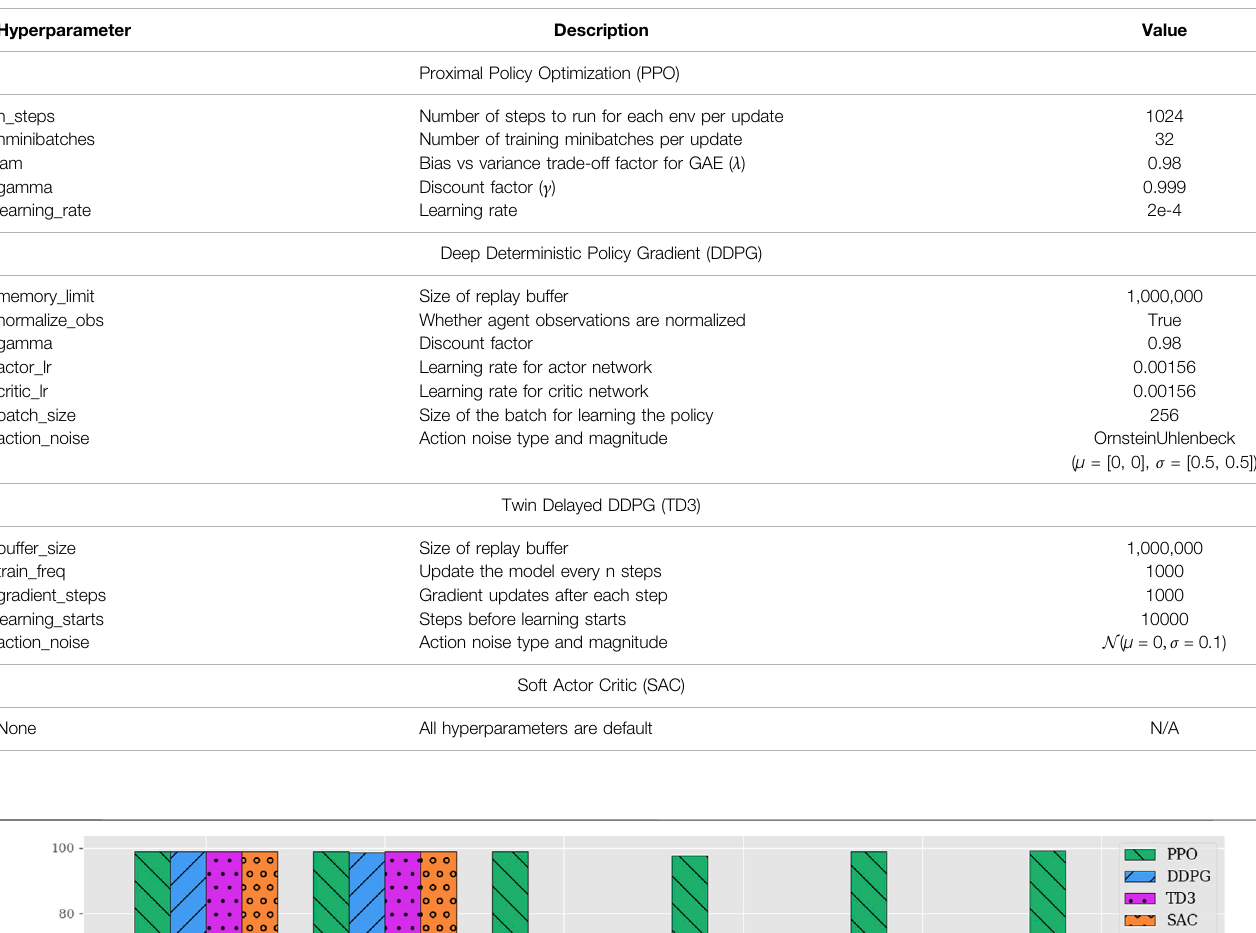
TABLE 3 | Non-default hyperparameters for each RL algorithm.